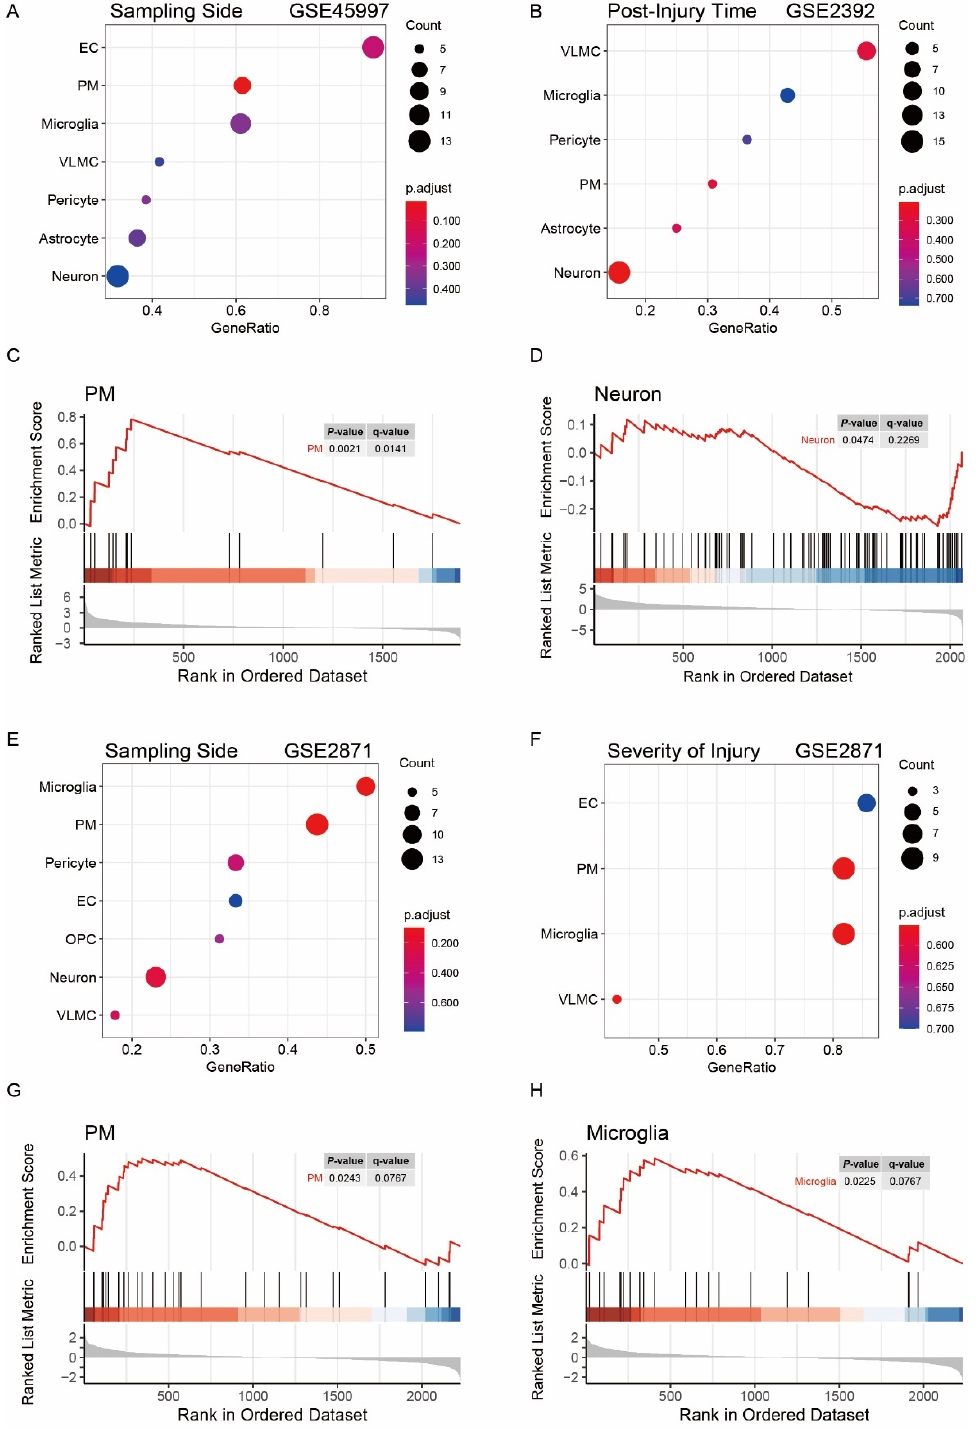
Figure 4. Gene set enrichment analysis (GSEA) of the genes in modules related to sample traits. ( A , C ) Dot plots illustrating cell types enriched in the genes in side-related modules using data from GSE45997 and the enrichment plots of PM; ( B , D ) dot plots illustrating cell types enriched in time-related modules using data from GSE2392 and the enrichment plots of neurons; ( E , G , H ) dot plots of the enrichments in side-related modules using data from GSE2871 and the enrichment plots of PM and microglia; ( F ) dot plots illustrating enriched cells in severity-related modules using data from GSE2871.